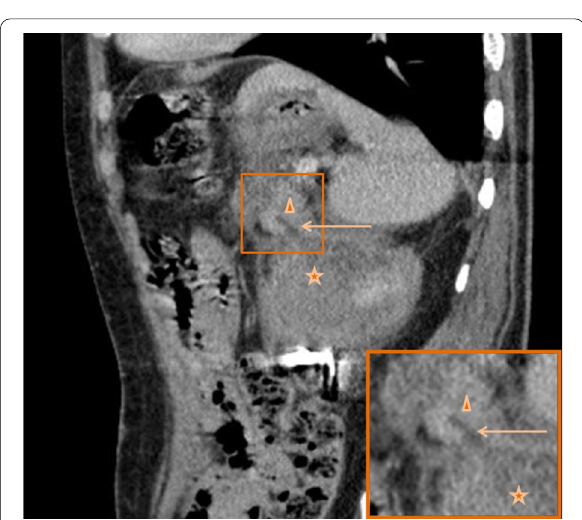
Fig. 5 Post-percutaneous drainage sagittal CECT abdomen demonstrating the pancreatico-perirenal fistula (arrow). — pancreatic